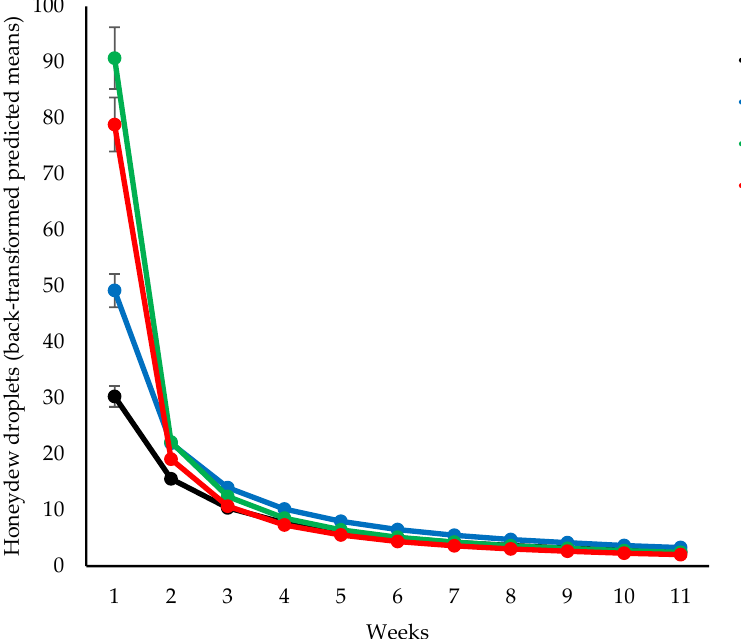
Figure 3. Honeydew secretion by different initial populations of O. lybicus in the period of eleven weeks following insect release. Predicted means with standard error bars are shown from generalized linear mixed model analysis for negative binomial distribution with link function of log ratio ( p = 0.049).